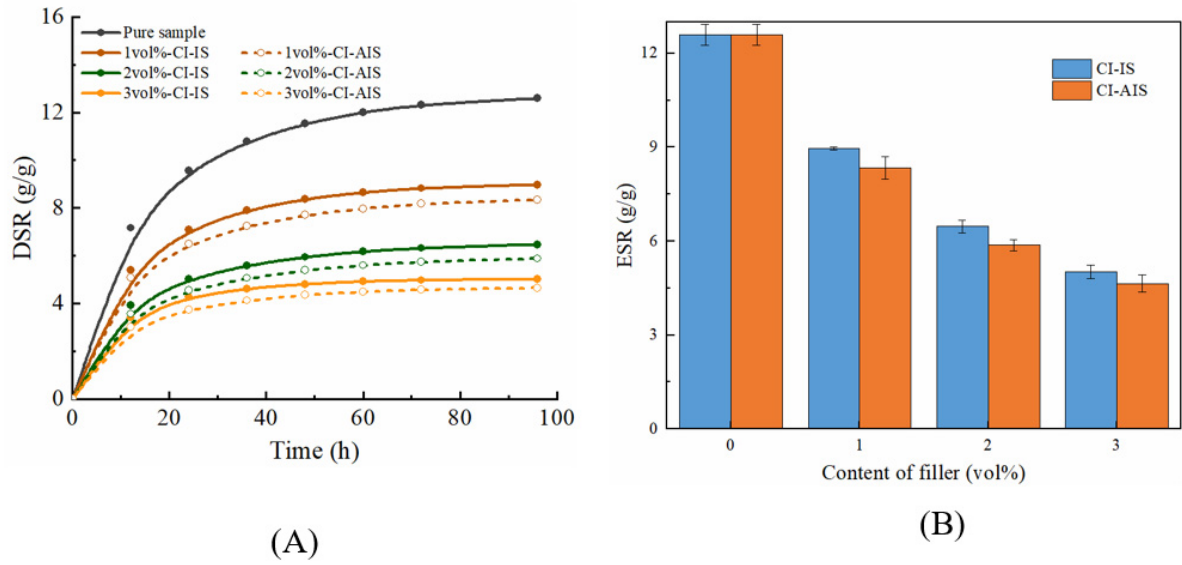
Figure 10. ( A ) The DSR plotted as a function of the swelling time for dried samples with different CI content in deionized water. ( B ) The effects of CI content on ESR.